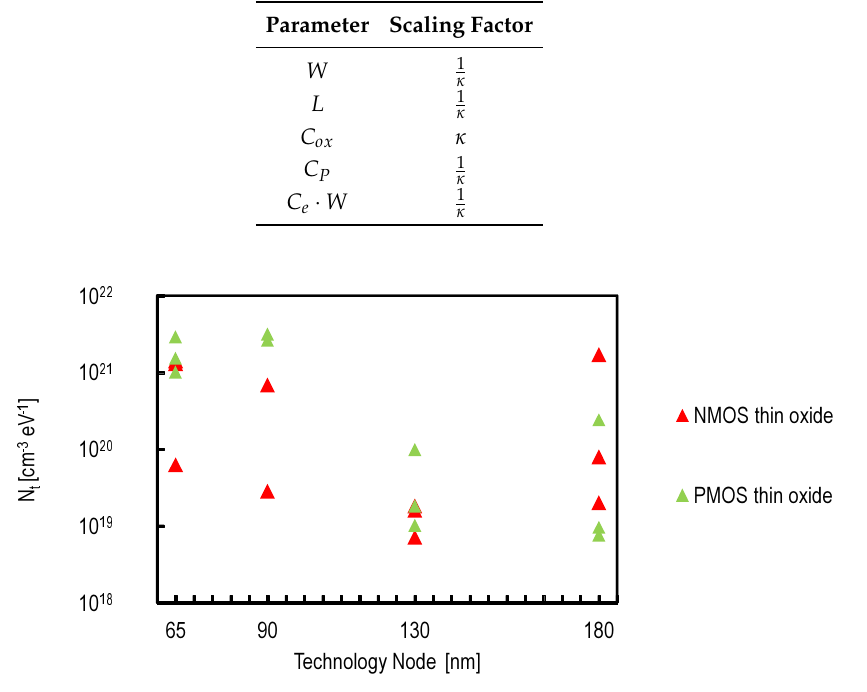
Figure 15. The evolution of the oxide trap density N t , as a function of the technology node based on measurement results reported in design kits from different